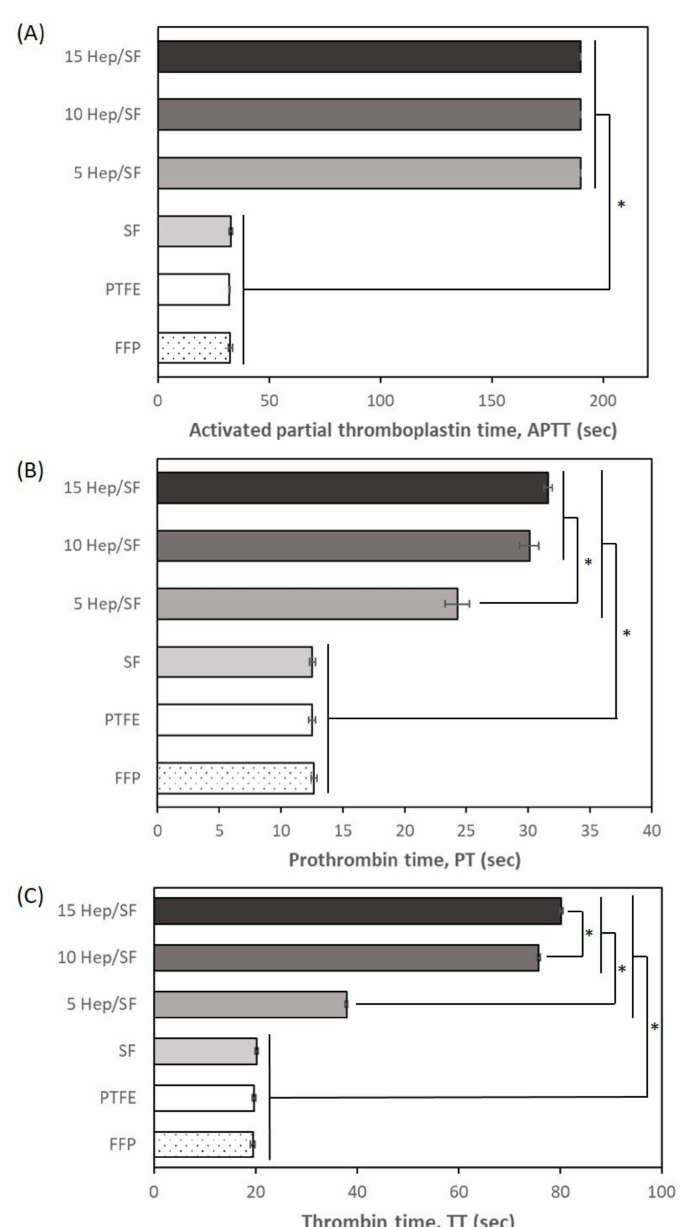
Figure 3. In vitro coagulation times including ( A ) activated partial thromboplastin time, APTT, ( B ) prothrombin time, PT, and ( C ) thrombin time, TT, of SF and Hep/SF films and PTFE sheet after 1 h of incubation. * p < 0.05 between the